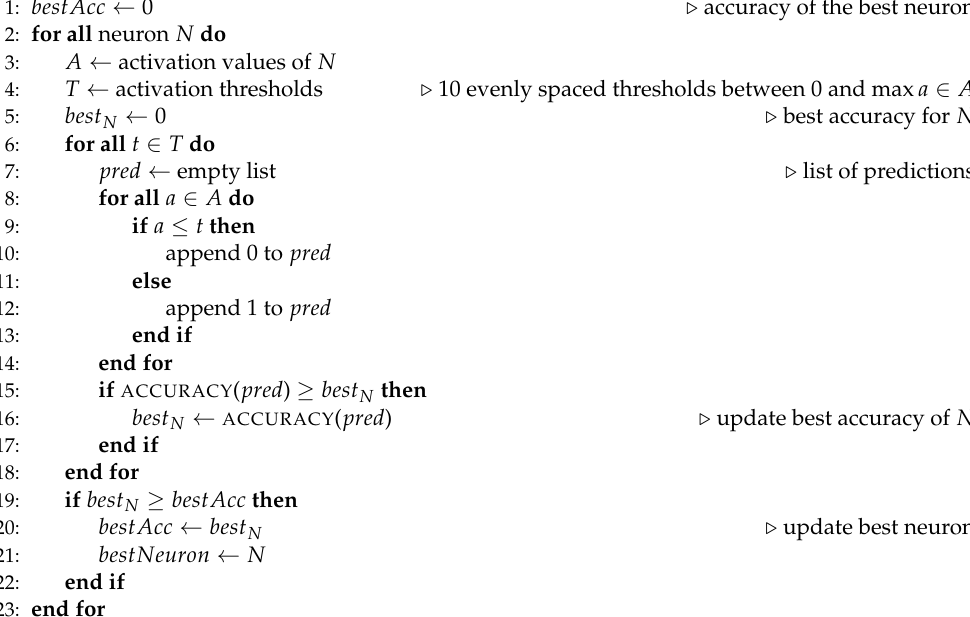
Algorithm 1 Algorithm for finding the best neuron in classifying programs on binary problems. The accuracy is computed by considering two balanced classes, each having at least 300